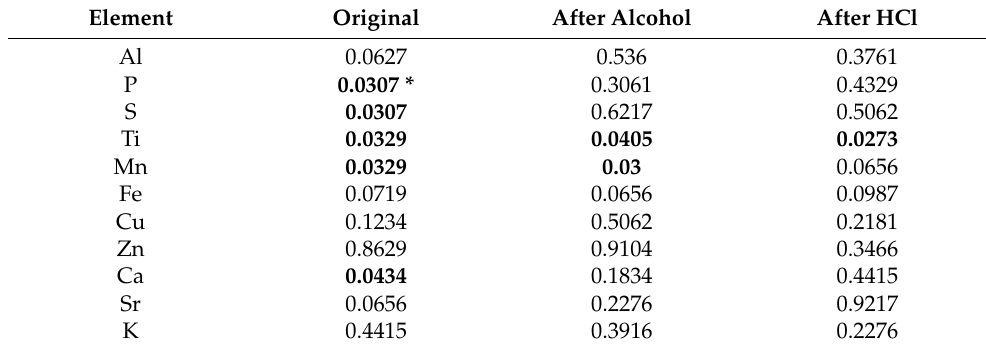
Table 1. Results of Kruskal–Wallis ANOVA: impact of species factor on variation of elemental counts. Element Original After Alcohol After HCl Al 0.0627 0.536 0.3761 P 0.0307